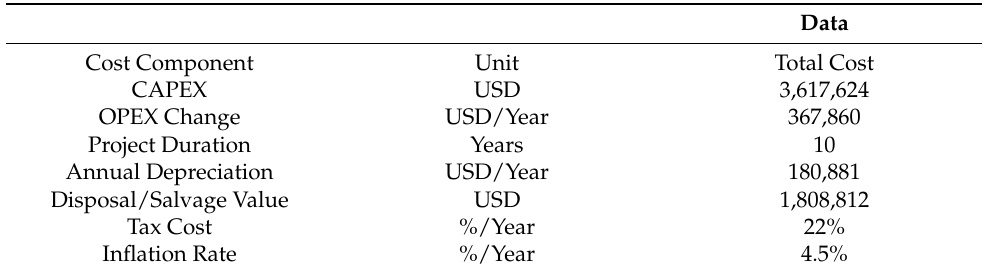
Table 6. Period 10-Year Scheme for Economic